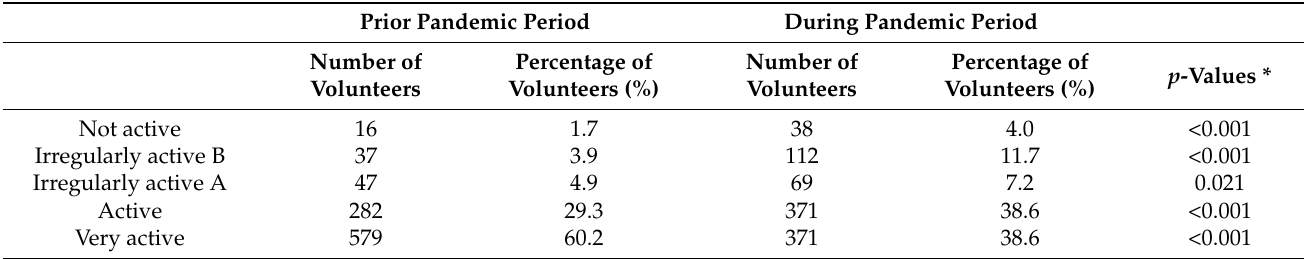
Table 2. Physical activity level adopted prior and during the pandemic period. Prior Pandemic